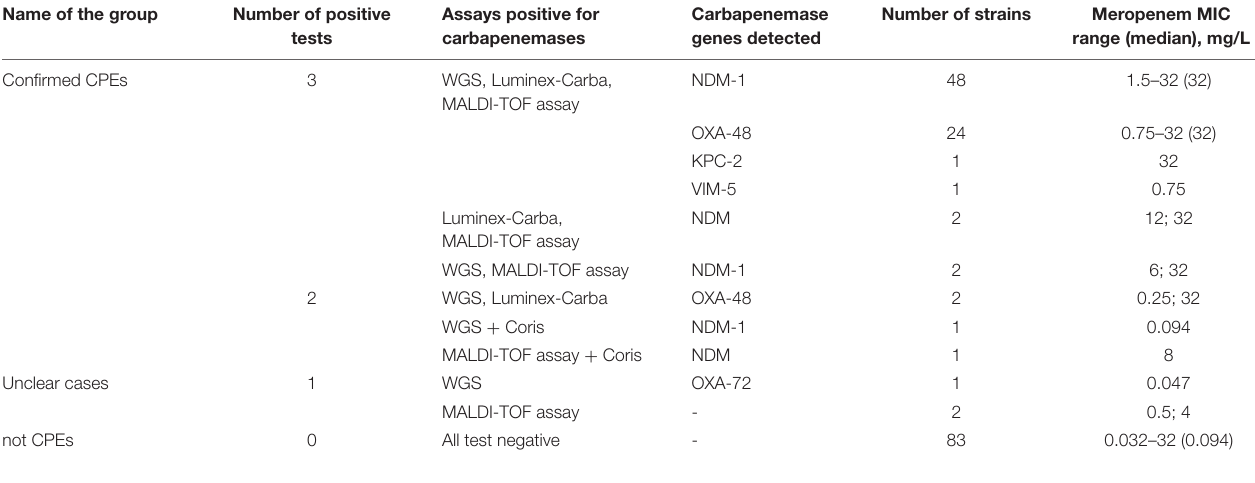
TABLE 1 | Correlation of different methods for detection of CPE and Meropenem MICs in K. pneumoniae ( n = 168). Name of the group Number of positive